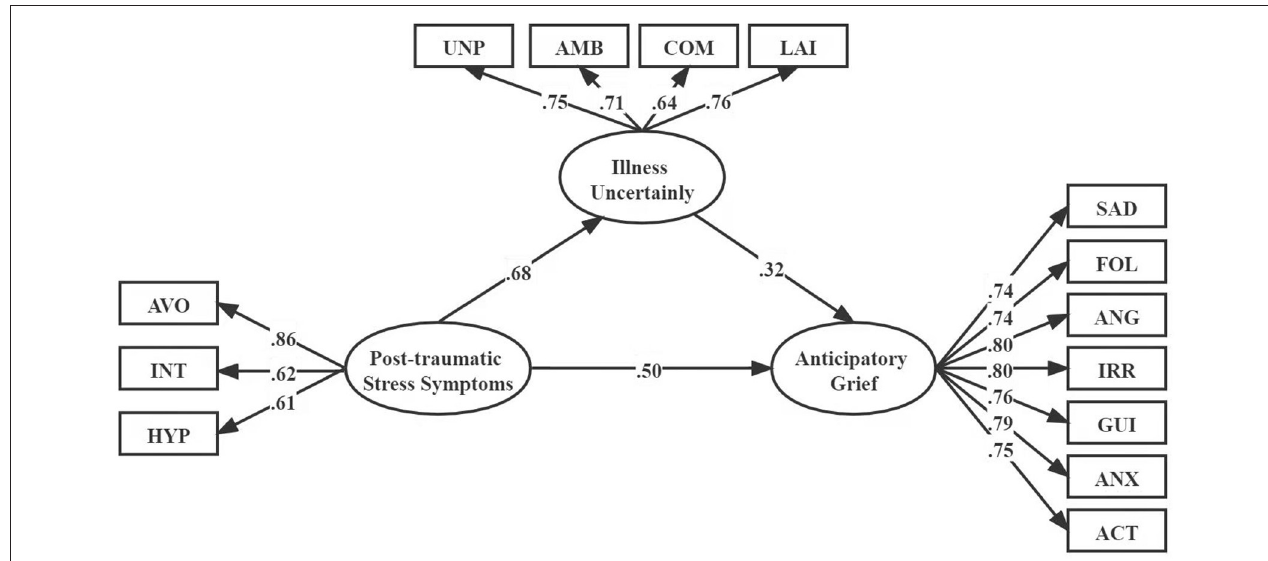
FIGURE 1 | Structural equation modeling of the hypothesized model. AVO, Avoidance; NT, Intrusion; HYP, Hyperarousal; UNP, Unpredictability; AMB, Ambiguity; COM, Complexity; LAI, Lack of Informativeness; SAD, Sadness; FOL, Feelings of Loss; ANG, Anger; IRR, Irritability; GUI, Guilt; ANX, Anxiety; ACT, Ability To Complete Tasks.